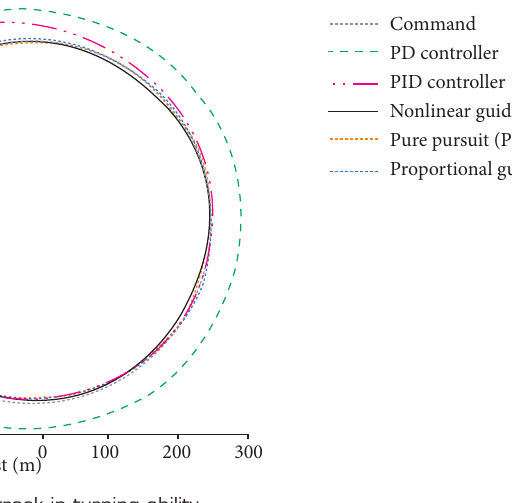
Figure 8. Circular track in turning ability. Figure 7 represents the 10-meter cross track in a linear straight maneuver. According to the results, the PN converges faster than others and PP converges to the straight line about 5 s later. Figure 8 shows the simulation setup and the associated results. Results indicate appropriate tracking with the guidance methods especially NGL, PN and PP.